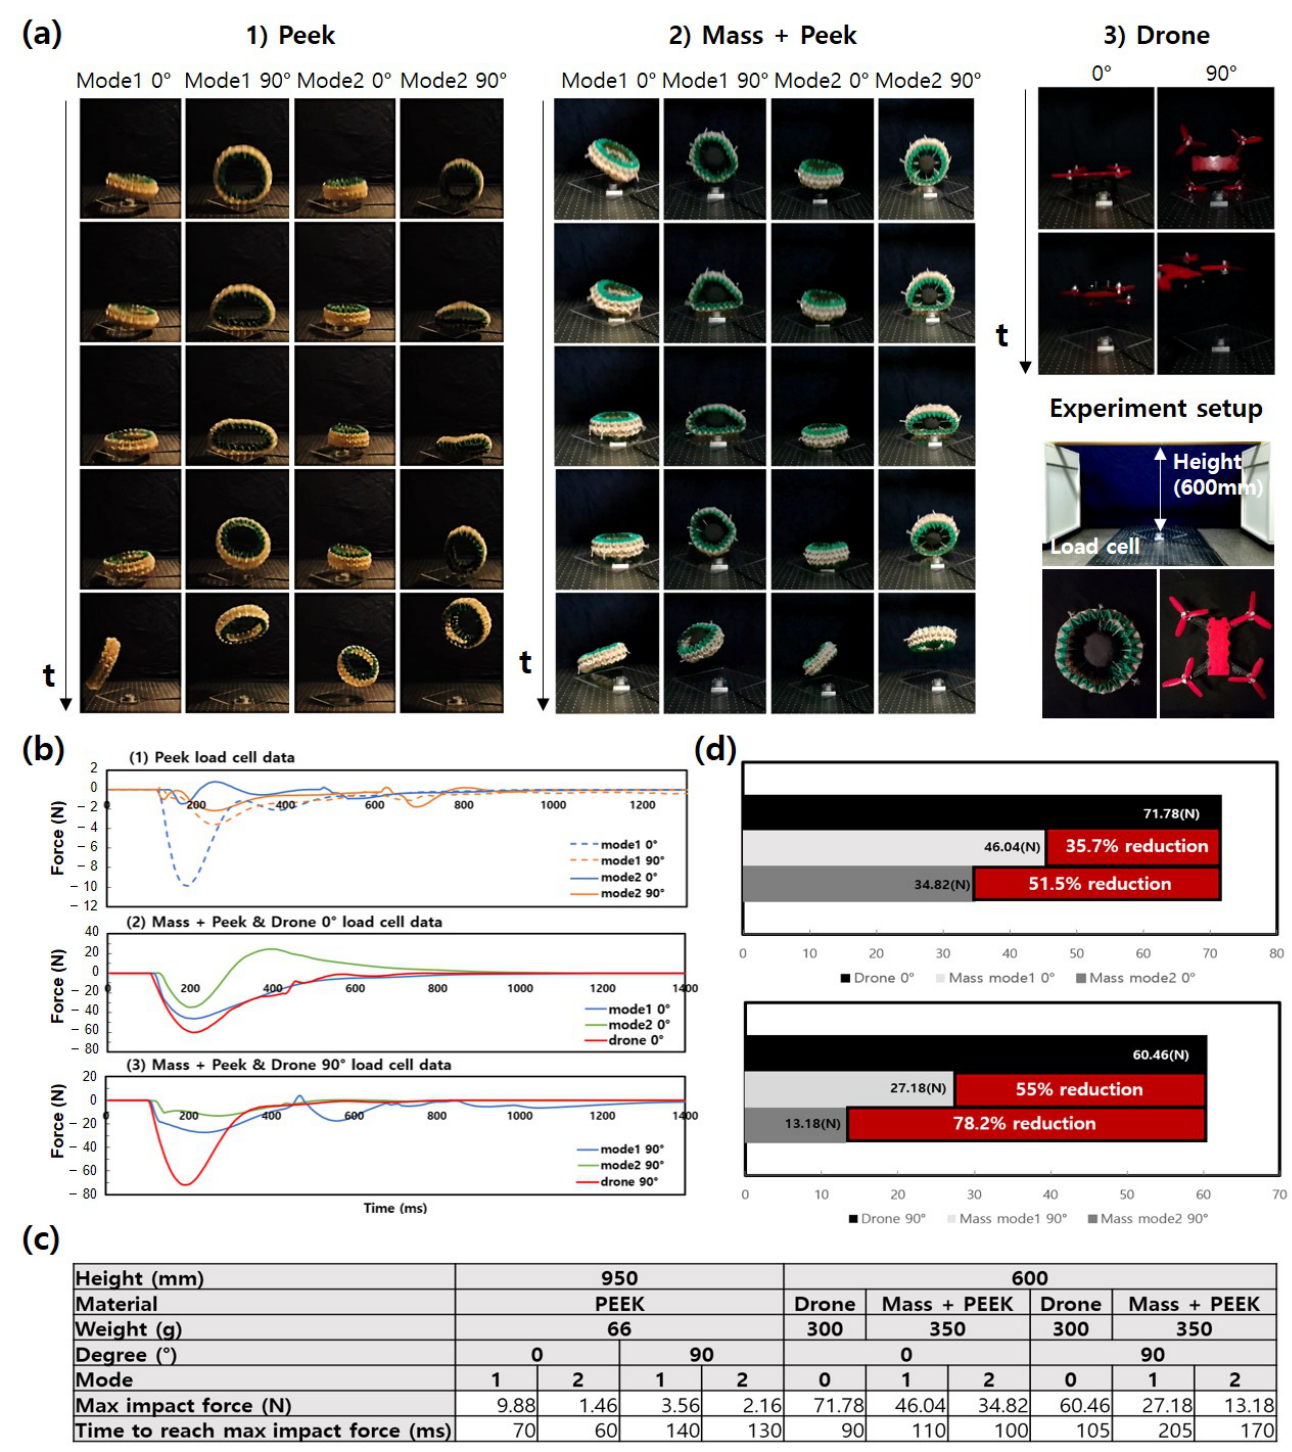
Figure 3. Drop impact test results. ( a ) Photographs of deformations on impact taken by a high-speed camera (Videos S3–S6), setup of the drop impact test. ( b ) Time–impact-force graphs. ( c ) Table with heights, materials, weights, angles, modes, maximum impact forces, and times to the maximum impact forces. ( d ) Maximum impact